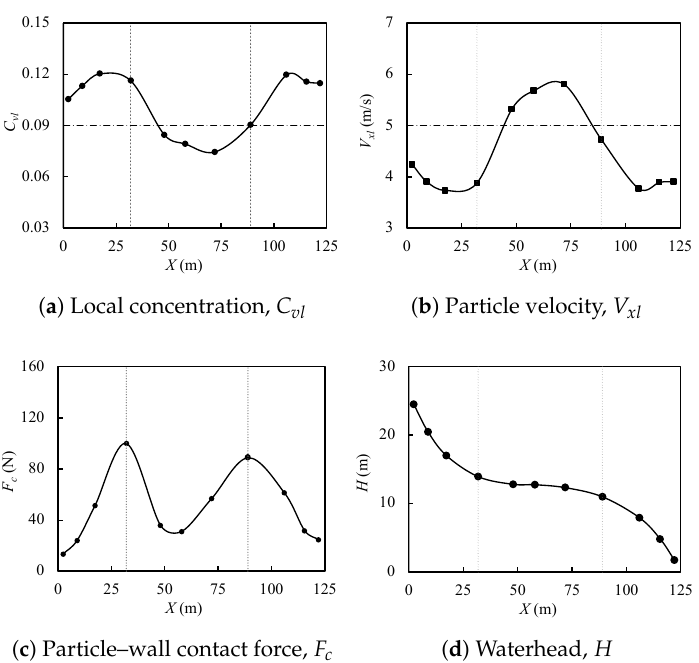
Figure 7. Time-averaged local characteristics of the mixture in the riser at C v 0 = 0.09, V m 0 = 5 m/s. The vertical dashed lines represent the peak and trough of the